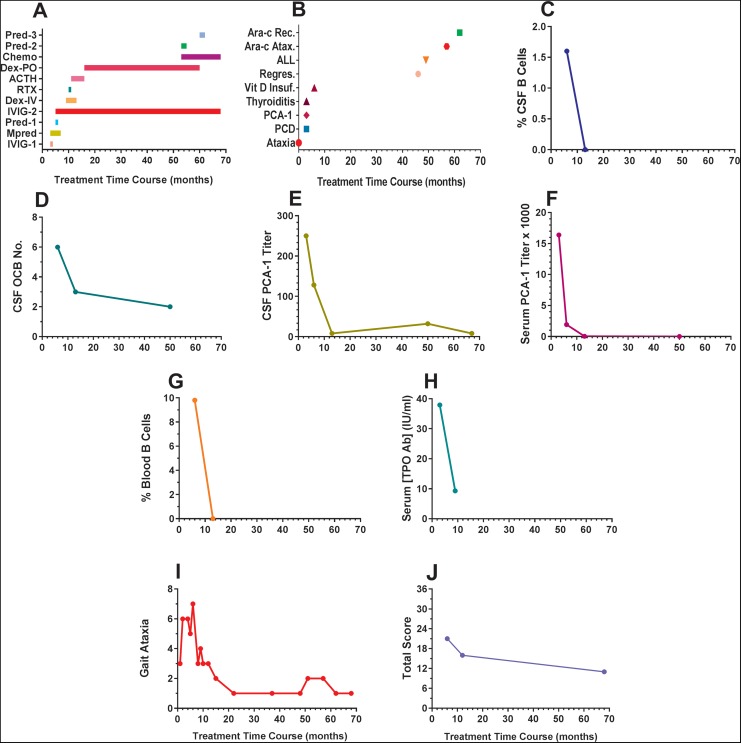
Time course of clinical and CSF measures and effect of immunotherapy. A, Treatment
record. Zero marks ataxia presentation. Sequence of treatment reads from bottom to top
of Y axis. The −1, −2, −3 suffixes on treatments refer to treatment periods, not
individual doses. Intravenous immunoglobulin (IVIG) was monthly; methylprednisolone
(MPRED) IV pulse; Adrenocorticotropic hormone (ACTH) twice daily, then daily, then
once a day SQ; DEX was 21 mg/m2 ÷ TID × 3 pulses, first intravenous, then
orally. Treatment in the first 12 months was for induction, then maintenance from 12
to 49 months, then for acute lymphocytic leukemia. More detailed reporting of doses
and dosing schedule are provided in Table 1. B, Sequence of diagnoses. C, Percent
CSF B cells. The control mean is < 1%. D, CSF OCB count. Per reference lab ≥ 2
bands is positive. E, CSF Purkinje cell cytoplasmic antibody type 1 titers. F, Serum
Purkinje cell cytoplasmic antibody type 1 titers. G, Percent blood cells. H, Thyroid
peroxidase antibody titers. Normal range is < 9.0 IU/mL. I, Ataxia score. Scale: 0,
normal; 1, walks independently, somewhat wide base, steady; 2, walks independently,
quite wide base, not falling; 3, walks independently, quite wide base, falling; 4,
requires walker, doable; 5, requires walker, difficult; 6, needs to hold on walls to
walk; 7, not independently walking; 8, nonambulatory. J, Total Score on a modified
Opsoclonus Myoclonus Evaluation Scale. Clinical interpretation is mild severity if
score 0 to 12; moderate, 13 to 24; severe, 25 to 36. Ara-cx Rec. indicates cytosine
arabinoside recovery; Ara-c Atax., cytosine arabinoside-induced cerebellar ataxia;
CSF, cerebrospinal fluid; DEX, dexamethasone; OCB, oligoclonal bands; PCD,
paraneoplastic cerebellar degeneration; Regres., regression (mild ataxia 1 week before
IVIG was due); Vit D Insuf., vitamin D insufficiency.